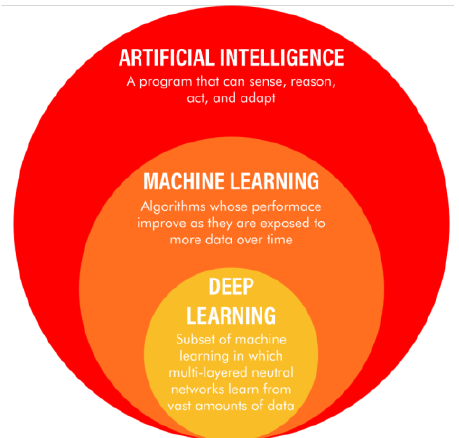
Figure 15. Subsets of artificial intelligence (Adapted from [23,24]).